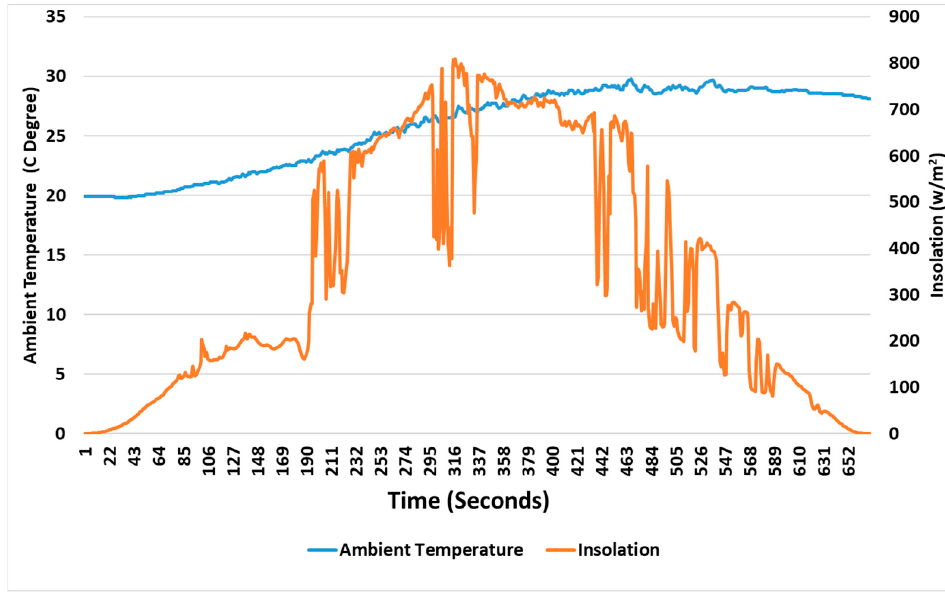
Figure 5. Curves of the actual insolation and ambient temperature for a cloudy day. Table 2. Parameters of the PO-MPPT and the proposed BES-MPPT.